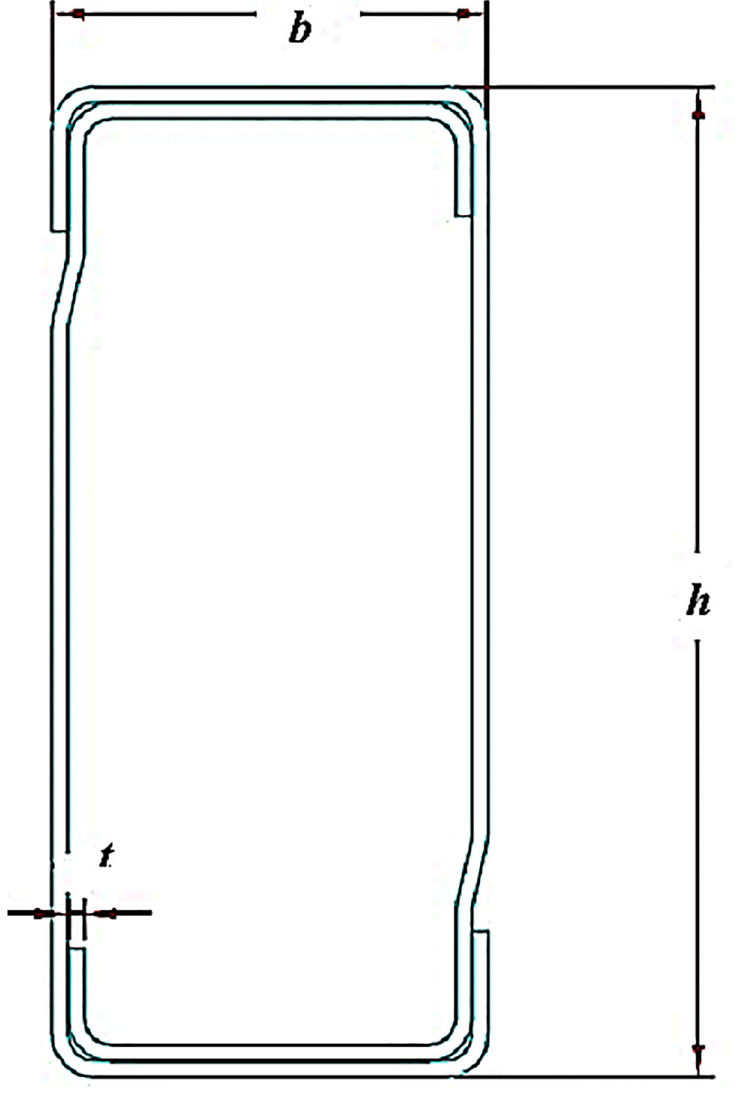
Fig 2. Cross-section of the